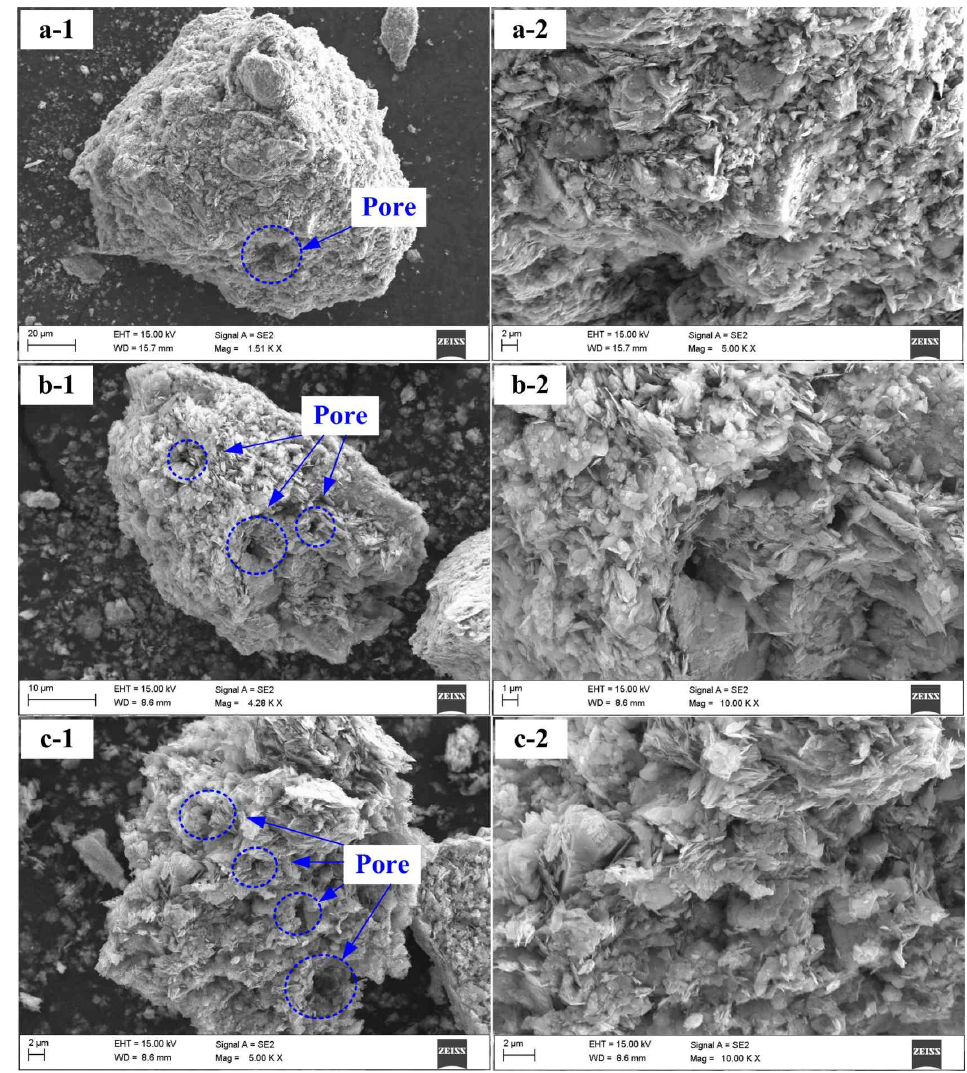
Figure 10. SEM images of materials at different roasting temperatures, with a CO concentration of 35% and roasting time of 5 min: ( a-1 , a-2 ) 550 °C, ( b-1 , b-2 ) 600 °C, ( c-1 , c-2 ) 650 °C.